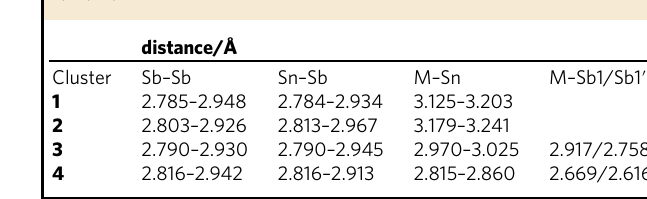
Table 1 Comparison of selected atomic distances for